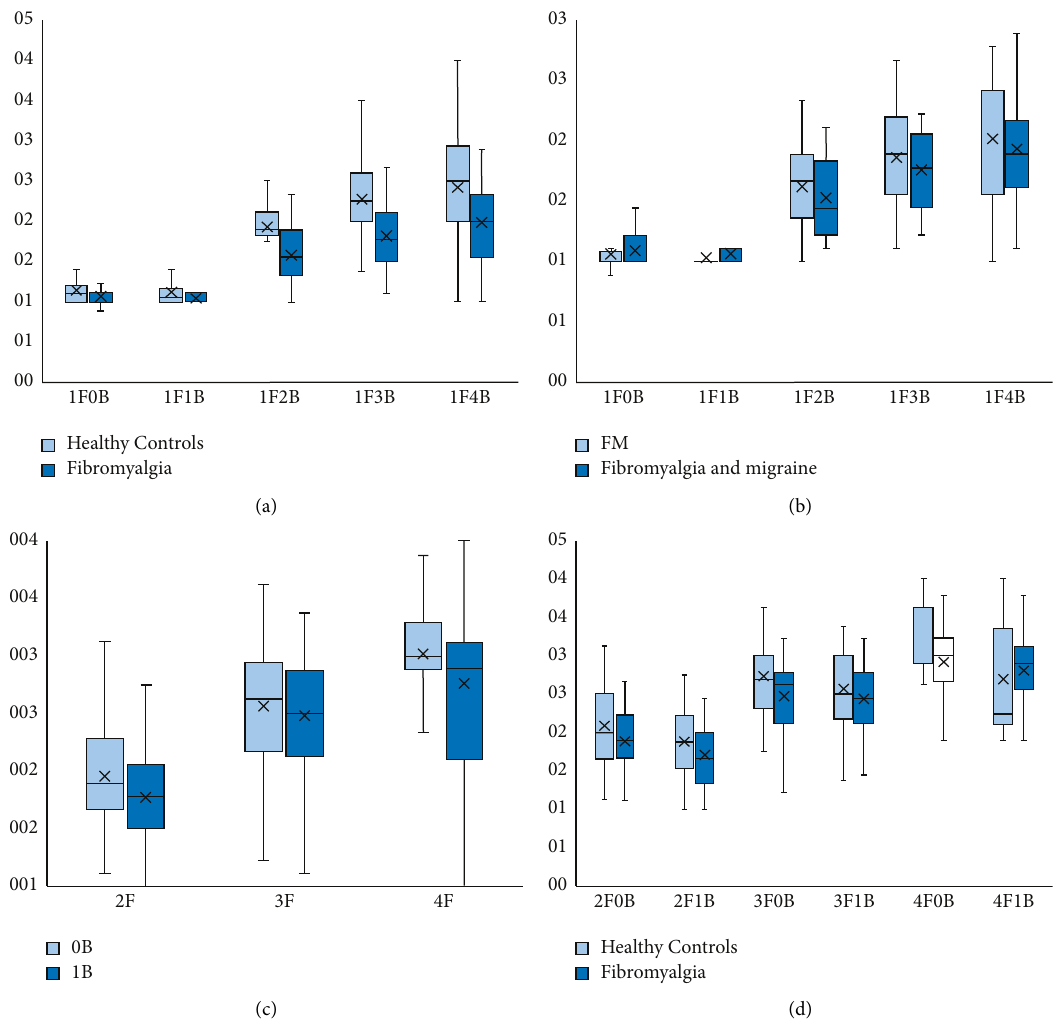
Figure 1: Box plots of SIFI for fission illusion (a–b) and fusion illusion trials (c–d). Fission illusion trials in patients affected by fibromyalgia compared to healthy controls (a) and comparison of fission illusion trials in patients with fibromyalgia with and without migraine (b). Comparison between 0B and 1B trials showing fusion illusory effect in all participants (c). Fusion illusions in patients affected by fibromyalgia compared to healthy controls (d). The fission and fusion illusion trials and the mean number of perceived flashes are reported in the horizontal and vertical axes, respectively. Median and interquartile ranges are